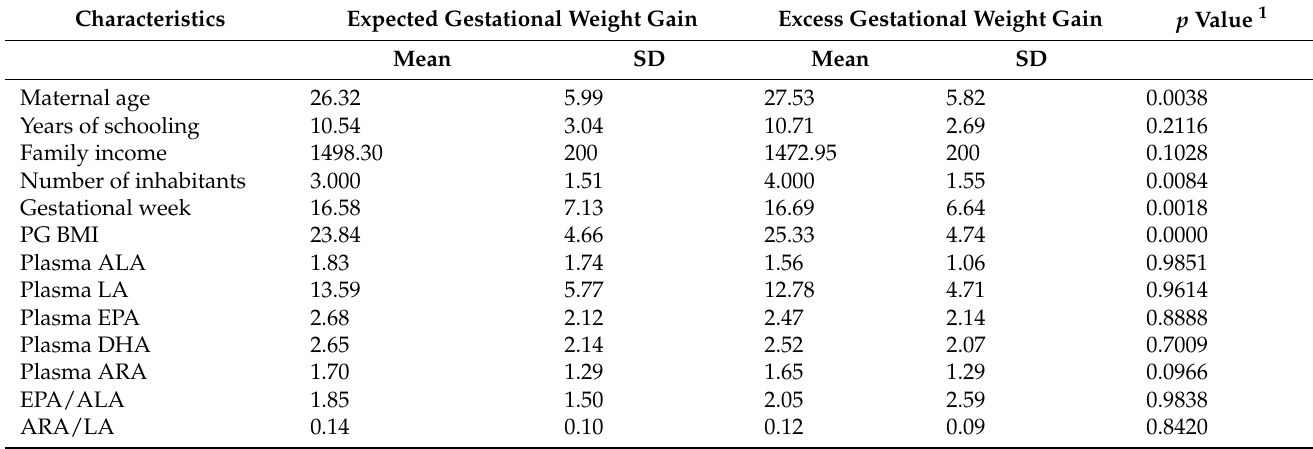
Table 1. Sociodemographic and nutritional characteristics according to weight gain throughout pregnancy. Santo Ant ô nio Jesus, Bahia, 2013–2014.